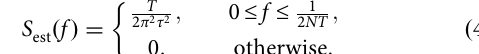
ð f Þ , limited by the statistical sampling ^ δ q q